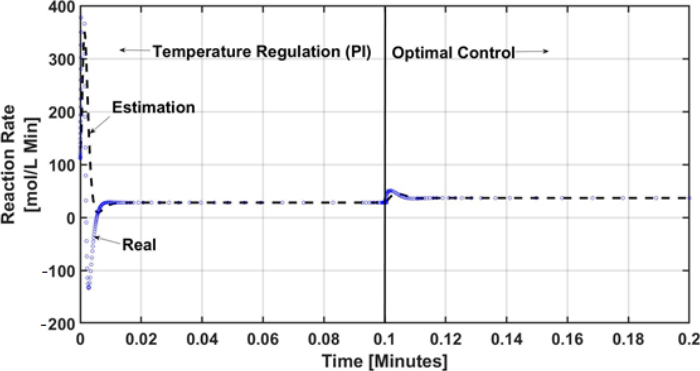
Figure 6. Dynamic performance of the uncertainty